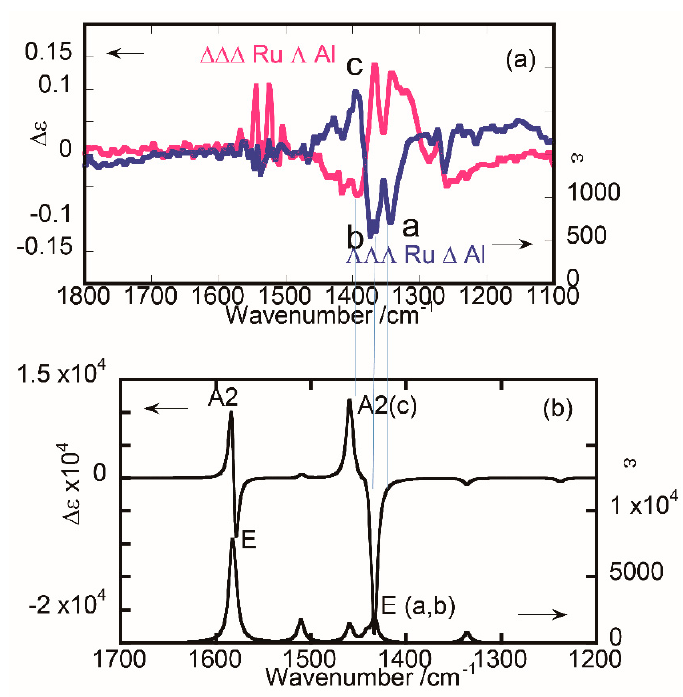
Figure 5. ( a ) Difference of VCD spectra between the initial and final states: (blue) [{ Λ -Ru(III)(acac) 2 (taet)} 3 Al(III)] or (red) [{ ∆ -Ru(III)(acac) 2 (taet)} 3 Al(III)] in CDCl 3 . ( b ) The calculated VCD and IR spectra of ∆ -[Al(III)(acac) 3 ] in a gas phase.